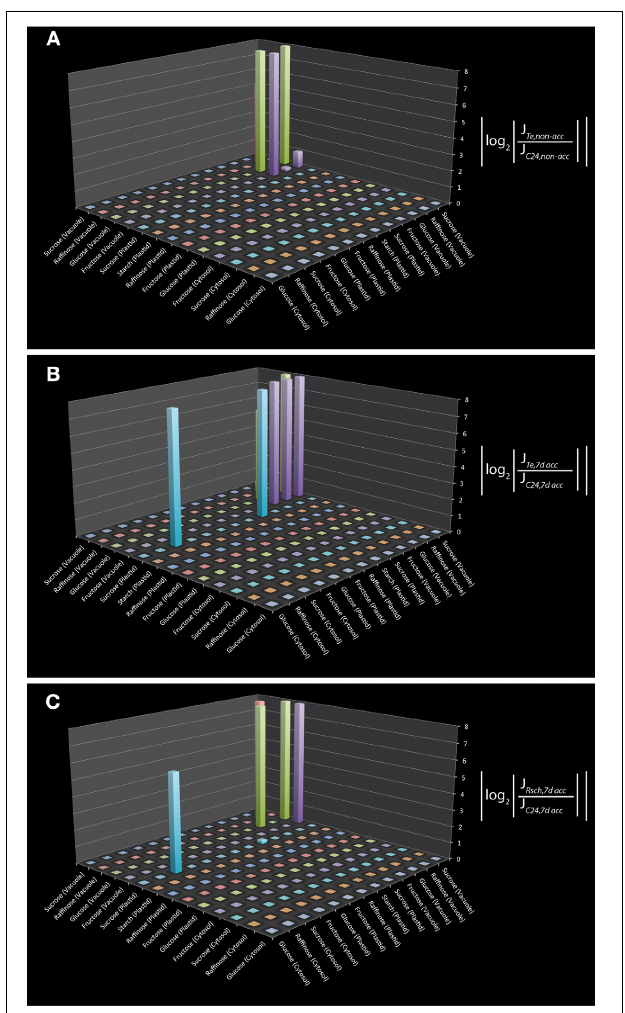
FIGURE 1 | Differential Jacobian matrices derived from inverse calculations on subcellular carbohydrate concentrations. Differential Jacobians were built for Te and C24 before (A) , and after (B) 7 days of cold exposure. For Rsch and C24, the differential Jacobian was built for 7 day cold exposed samples (C) . Experimental data were taken from a previous study (Nägele and Heyer, 2013). Metabolic interaction sites are indicated on the horizontal x- and y-axis by the metabolites which participate in the reaction that is characterized by the entry of the Jacobian matrix. For example, in (B) the interaction of plastidial and cytosolic sucrose is significantly different between Te and C24 (non-diagonal blue bar). This can also be observed in (C) but not in (A)